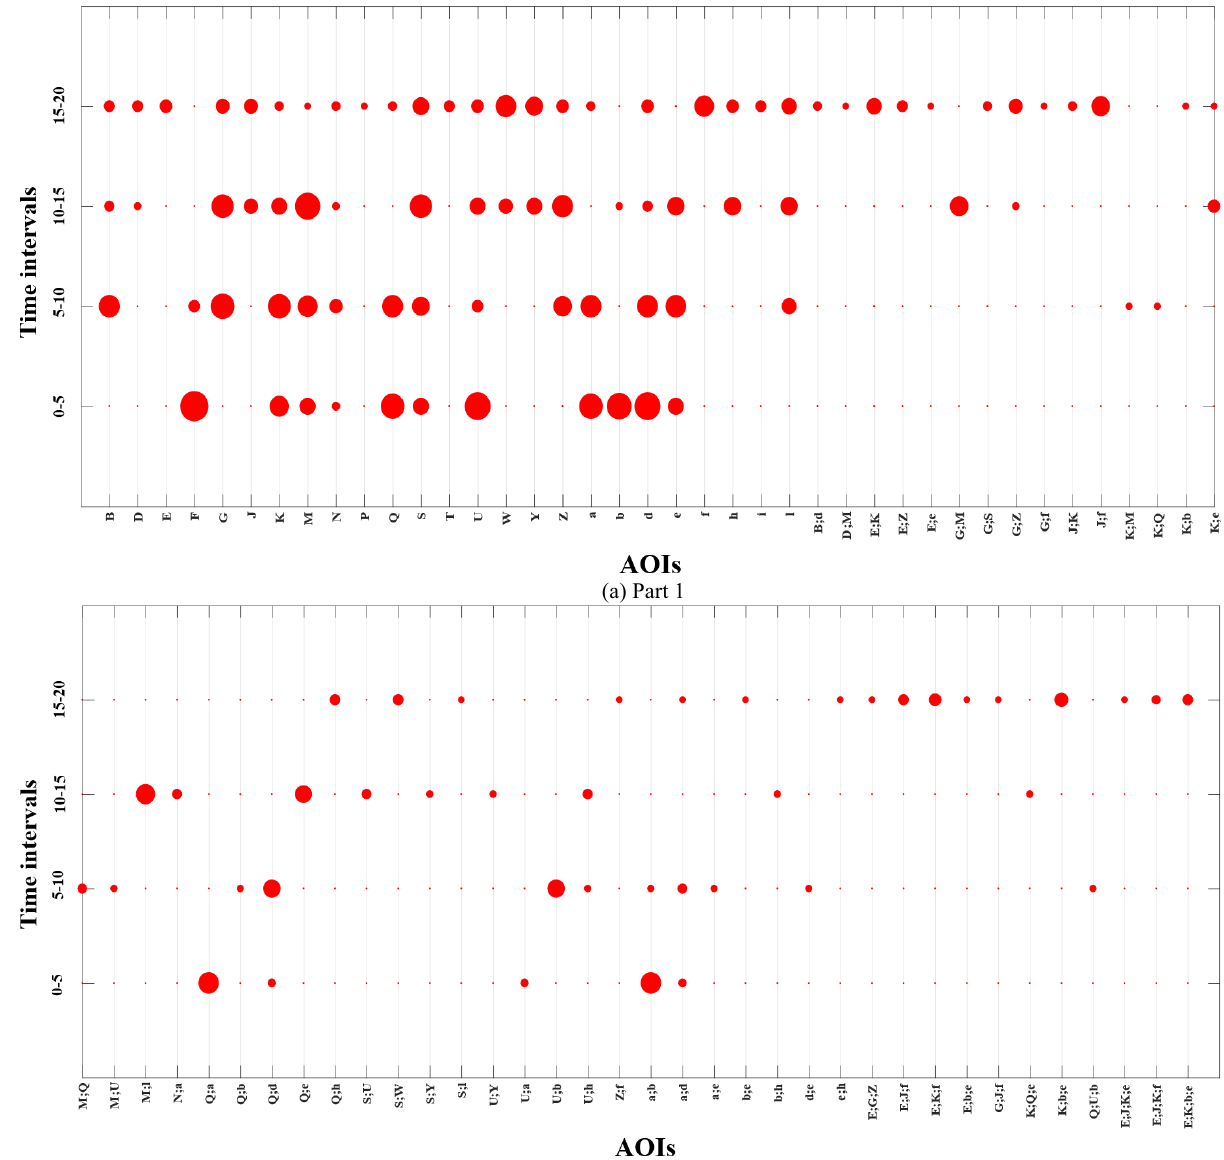
Figure 9. Adapted dot plot visualization of the percent normalized indegree measure value for all AOIs (single and overlapped) present in the DNet visualization in Figure